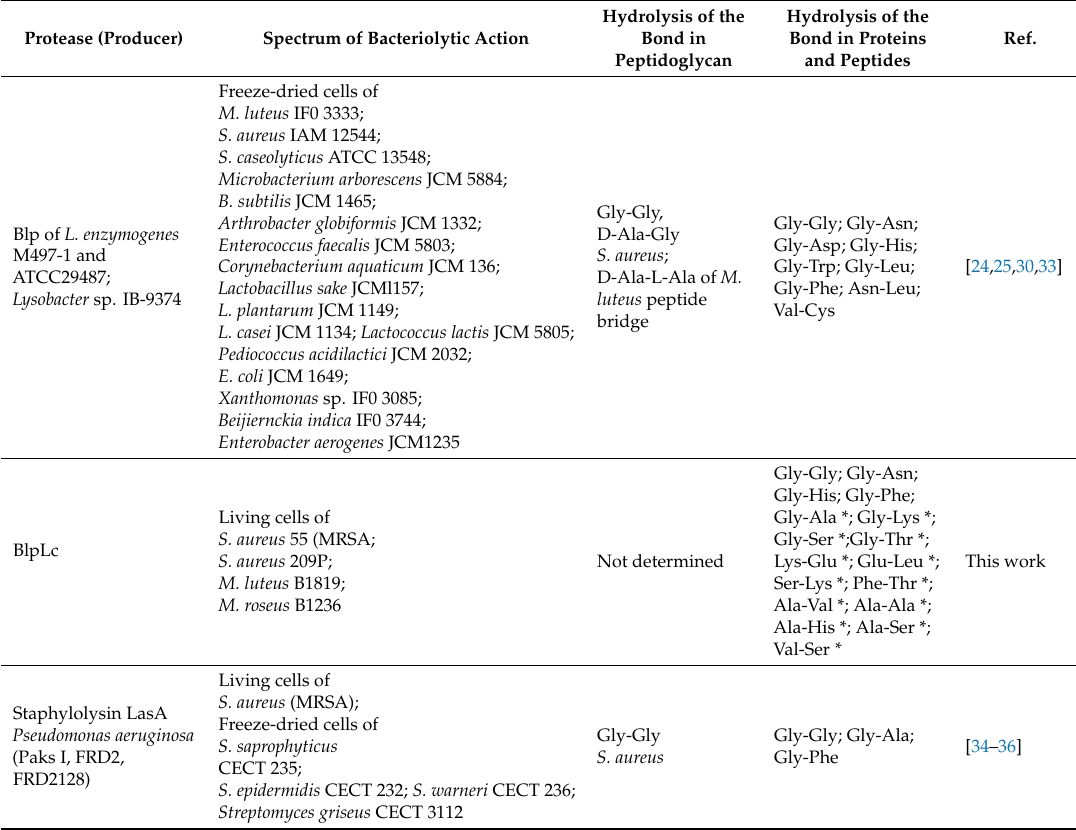
Table 6. Specificities of bacteriolytic proteases